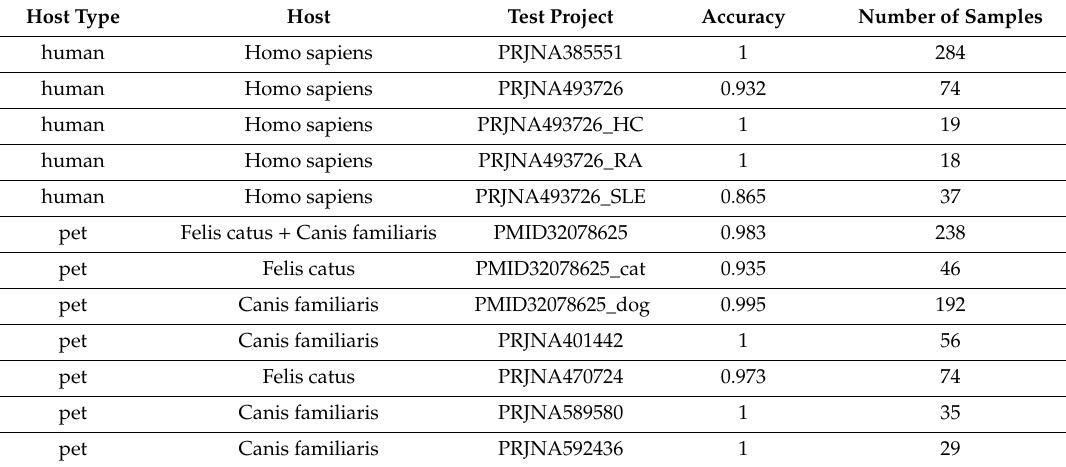
Table 3. Accuracy of Genus_MW-FDR model on additional